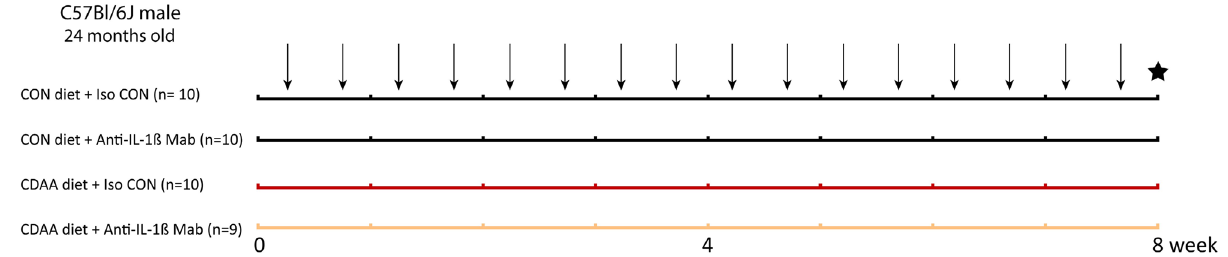
Figure 6. Experimental protocol. 24-months-old C57Bl/6J mice were fed with CDAA or CON diet for 8 weeks. Black arrows indicate intraperitoneal treatments with isotype control or anti-IL-1β Mab (50 µg/mice). The black star indicates the termination of mice, when blood and organ samples were collected. CDAA, Choline Deficient L-Amino Acid-defined diet; CON, control diet; Iso CON, isotype control; Anti-IL-1β, anti-interleukin-1β monoclonal